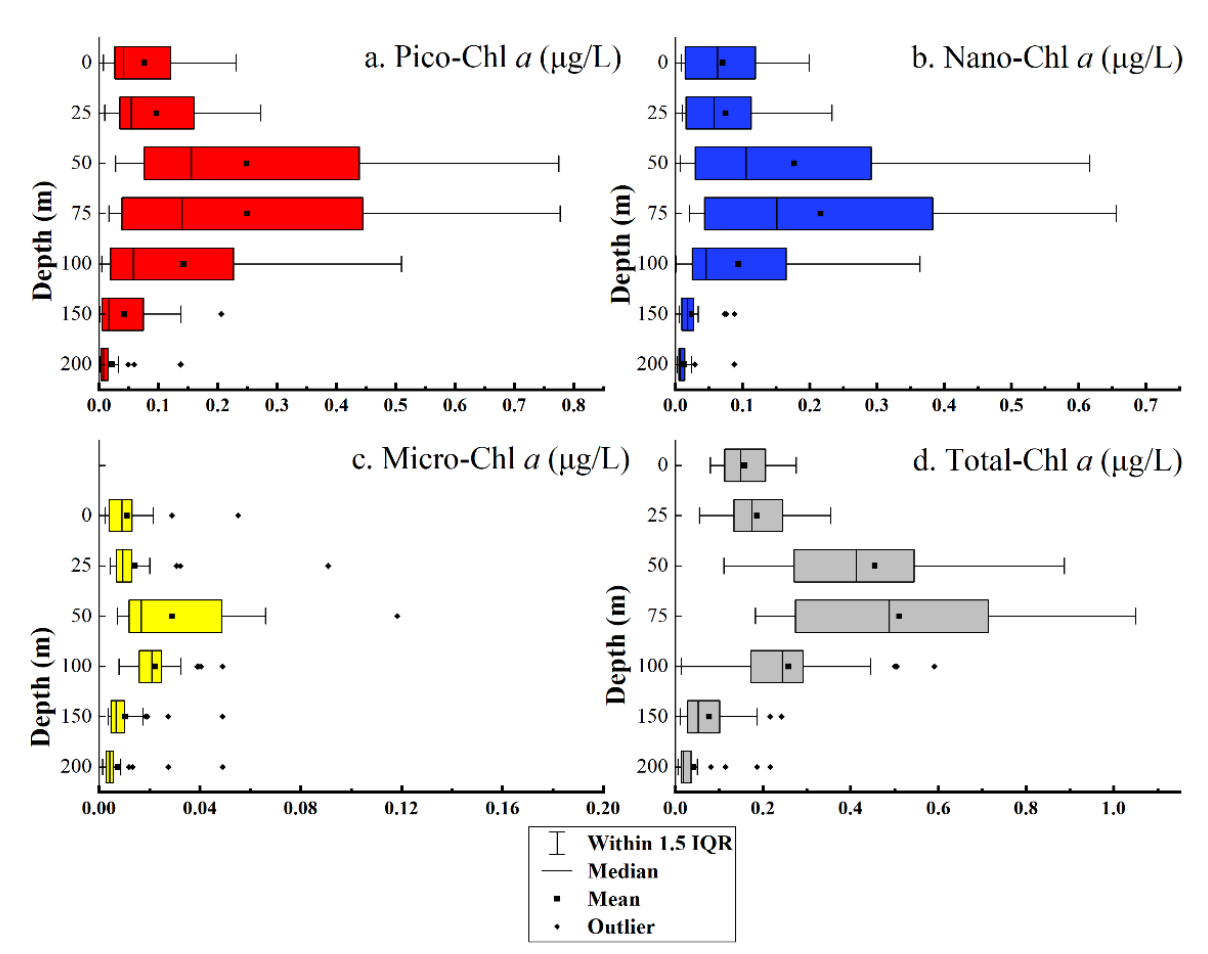
Figure 5. Vertical distribution of size-fractionated Chl a.